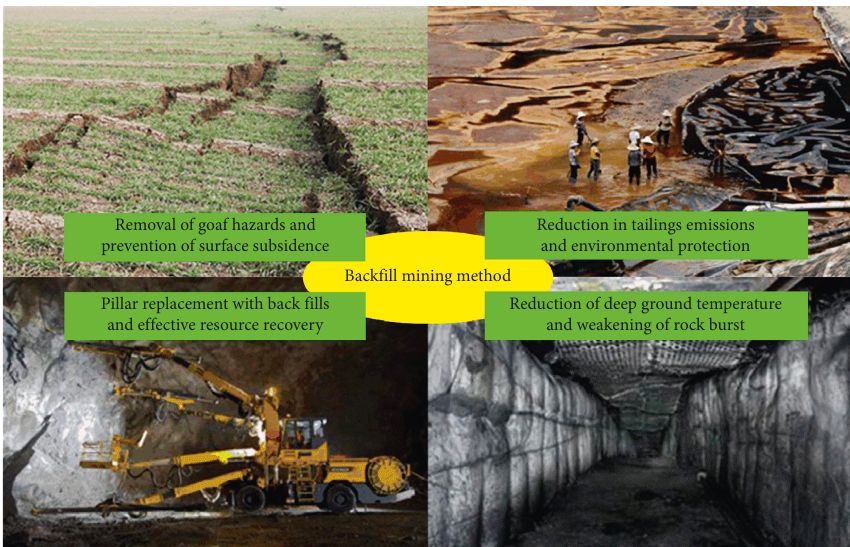
Figure 1: Superiority of the backfill mining method over the traditional open-stope method. Table 1: Successful cases of the backfill mining method used in complicated mining conditions.